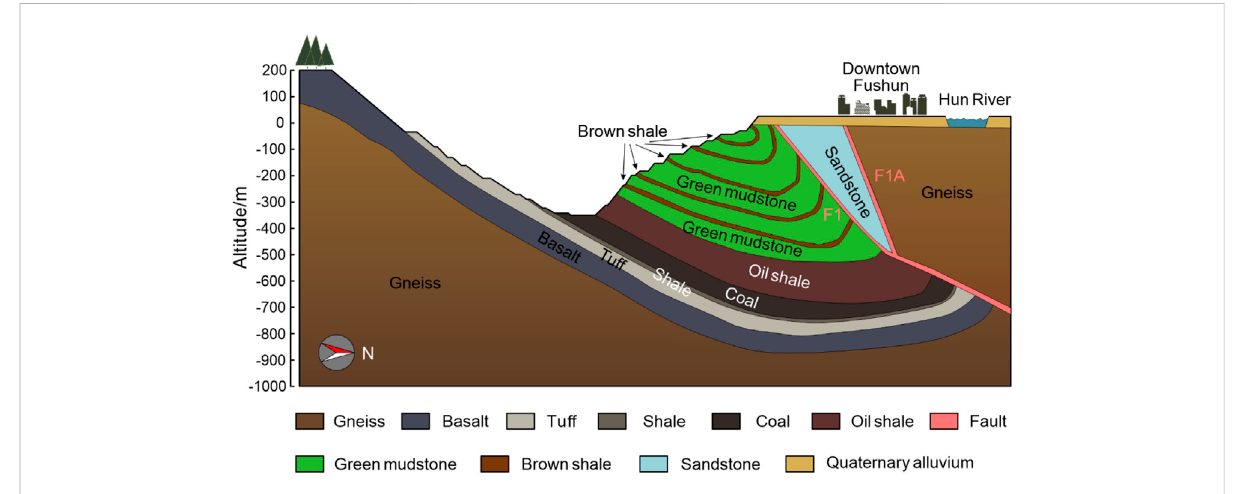
FIGURE 5 Pro fi le of E1600 in the Fushun West Open-Pit coal mine.